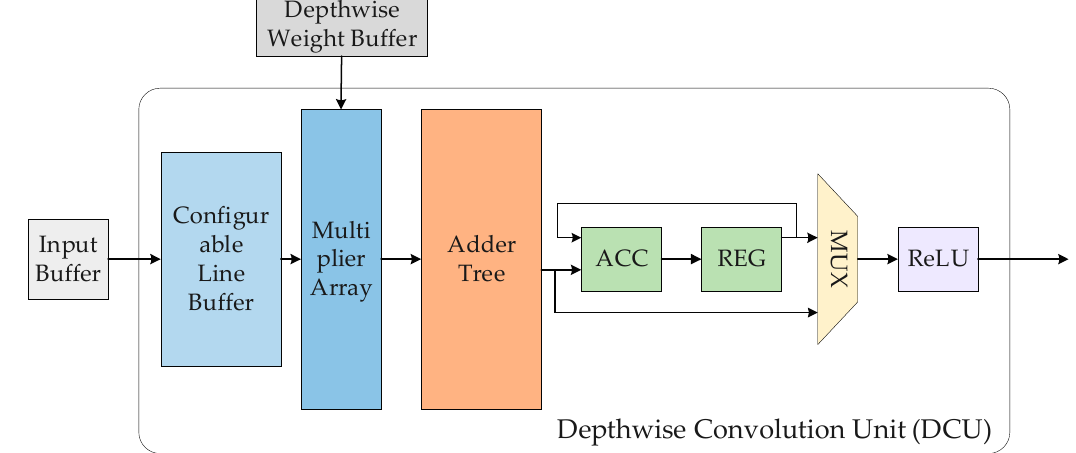
Figure 2. The block diagram of depth-wise convolution unit (DCU).